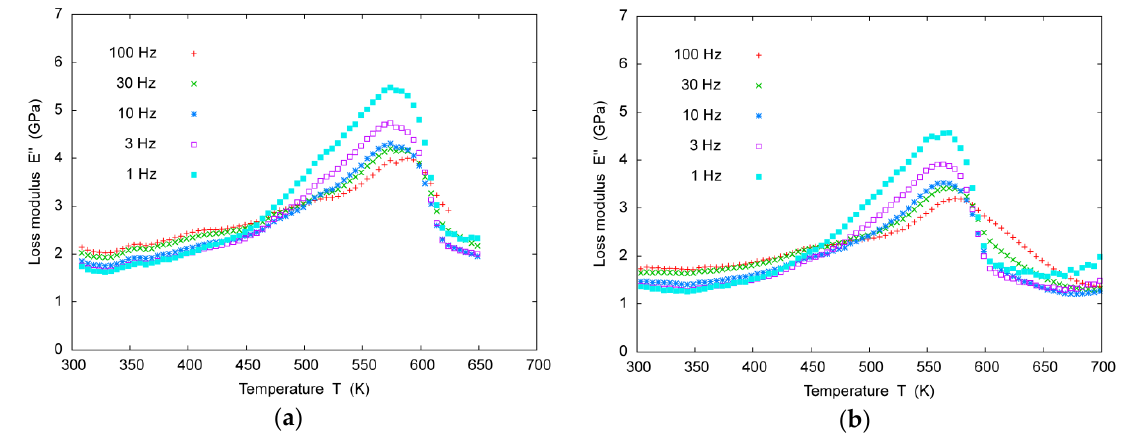
Figure 2. Loss modulus E ” vs. temperature T from dynamic-mechanical analyzer tests at frequencies ranging from 1–100 Hz: ( a ) for pure Al in the H24 temper, from room temperature (RT) to 648 K; ( b ) for pure Al, from RT to 723 K.